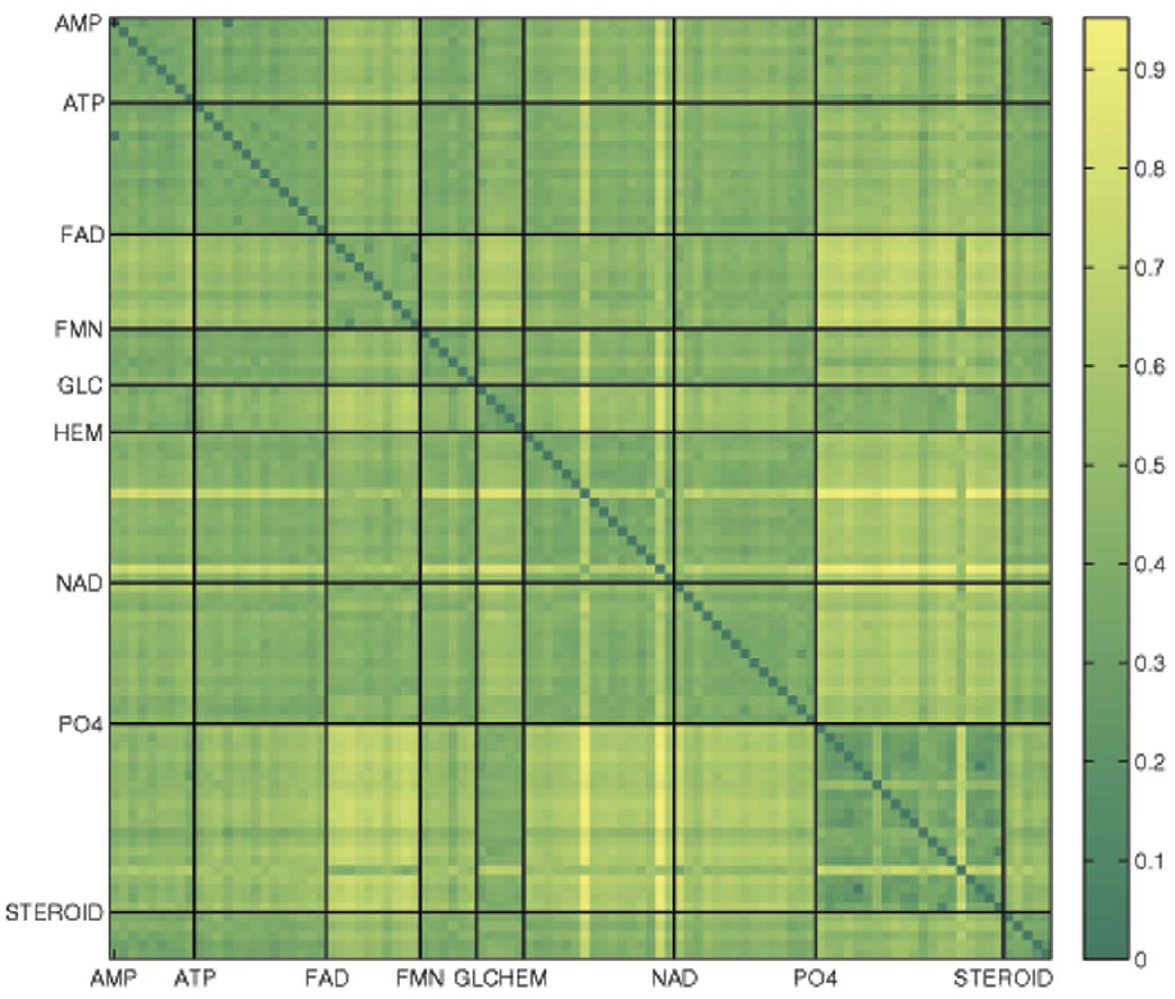
Figure 1. Similarity matrix computed using the TIPSA-TI + Gyr model. Dark pixels represent greater similarity and light pixels correspond to less similarity. The steroid group consists of both the AND and EST ligand groups in accordance to Kahraman et al (2007).